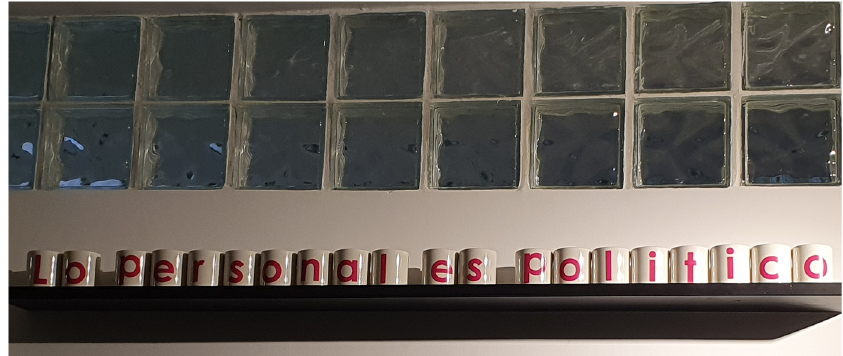
Figure 7. Photograph by the author of this essay. Barranquilla, November 2022.